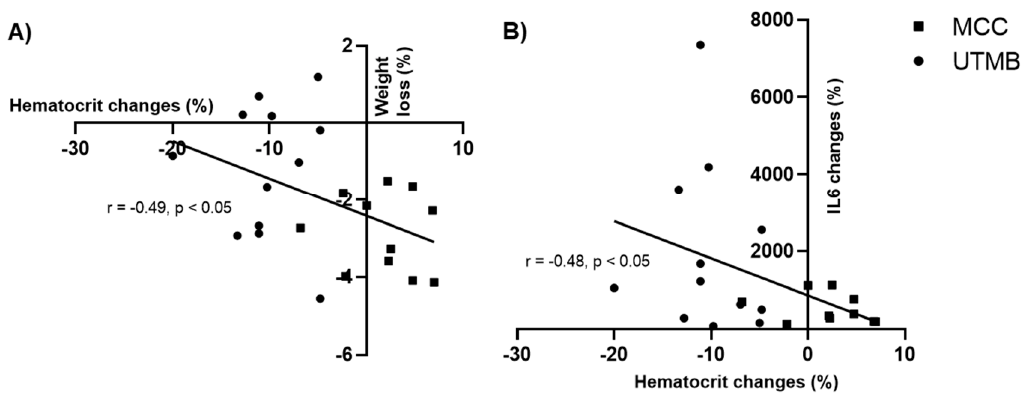
Figure 3. Correlations between the changes in hematocrit observed in both races and ( A ) weight loss; ( B ) IL-6 changes. All changes are expressed in percent of the resting values.